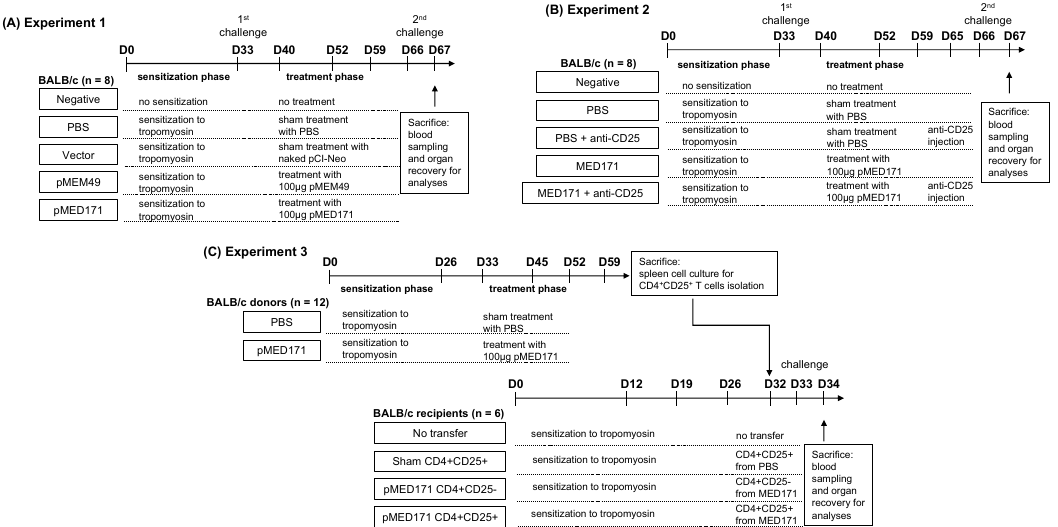
Figure 6. Study design of animal experiments. ( A ) Experiment 1 for assessing the therapeutic e ffi cacies of pMEM49 and pMED171. BALB / c mice ( n = 8) were randomly divided into control and treatment groups. Subsequent to the sensitization phase and first challenge, animals were either sham-treated with PBS, naked vector, pMEM49, or pMED171. Second tropomyosin challenge was delivered one week after the last treatment. ( B ) Experiment 2 for assessing the function of pMED171-induced Treg cells by anti-CD25 antibody-mediated Treg cell depletion. Following sensitization and treatment phases, selected groups of animals ( n = 8 per group) were dosed intraperitoneally with anti-CD25 antibody functional roles of pMED171-induced Treg cells by adoptive transfer method. CD4 + CD25 − T cells and CD4 + CD25 + Treg cells were isolated from donor mice receiving tropomyosin sensitization with/without pMED171 treatment ( n = 12). Cells were transferred intravenously to recipient mice sensitized with tropomyosin 24 h before tropomyosin challenge ( n = 6 per group). Animals from all experiments were sacrificed 24 h after allergen challenge for blood sampling and organ recovery for analyses.